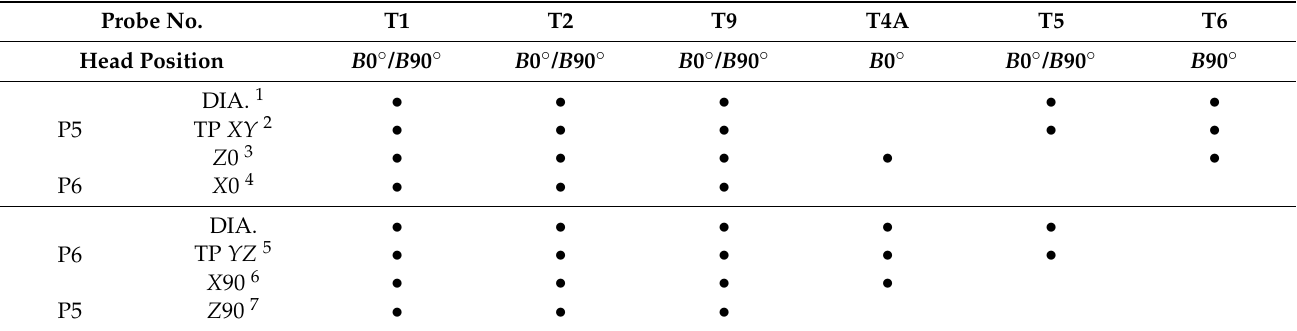
Table 3. Probing pattern for all probe configurations used for the